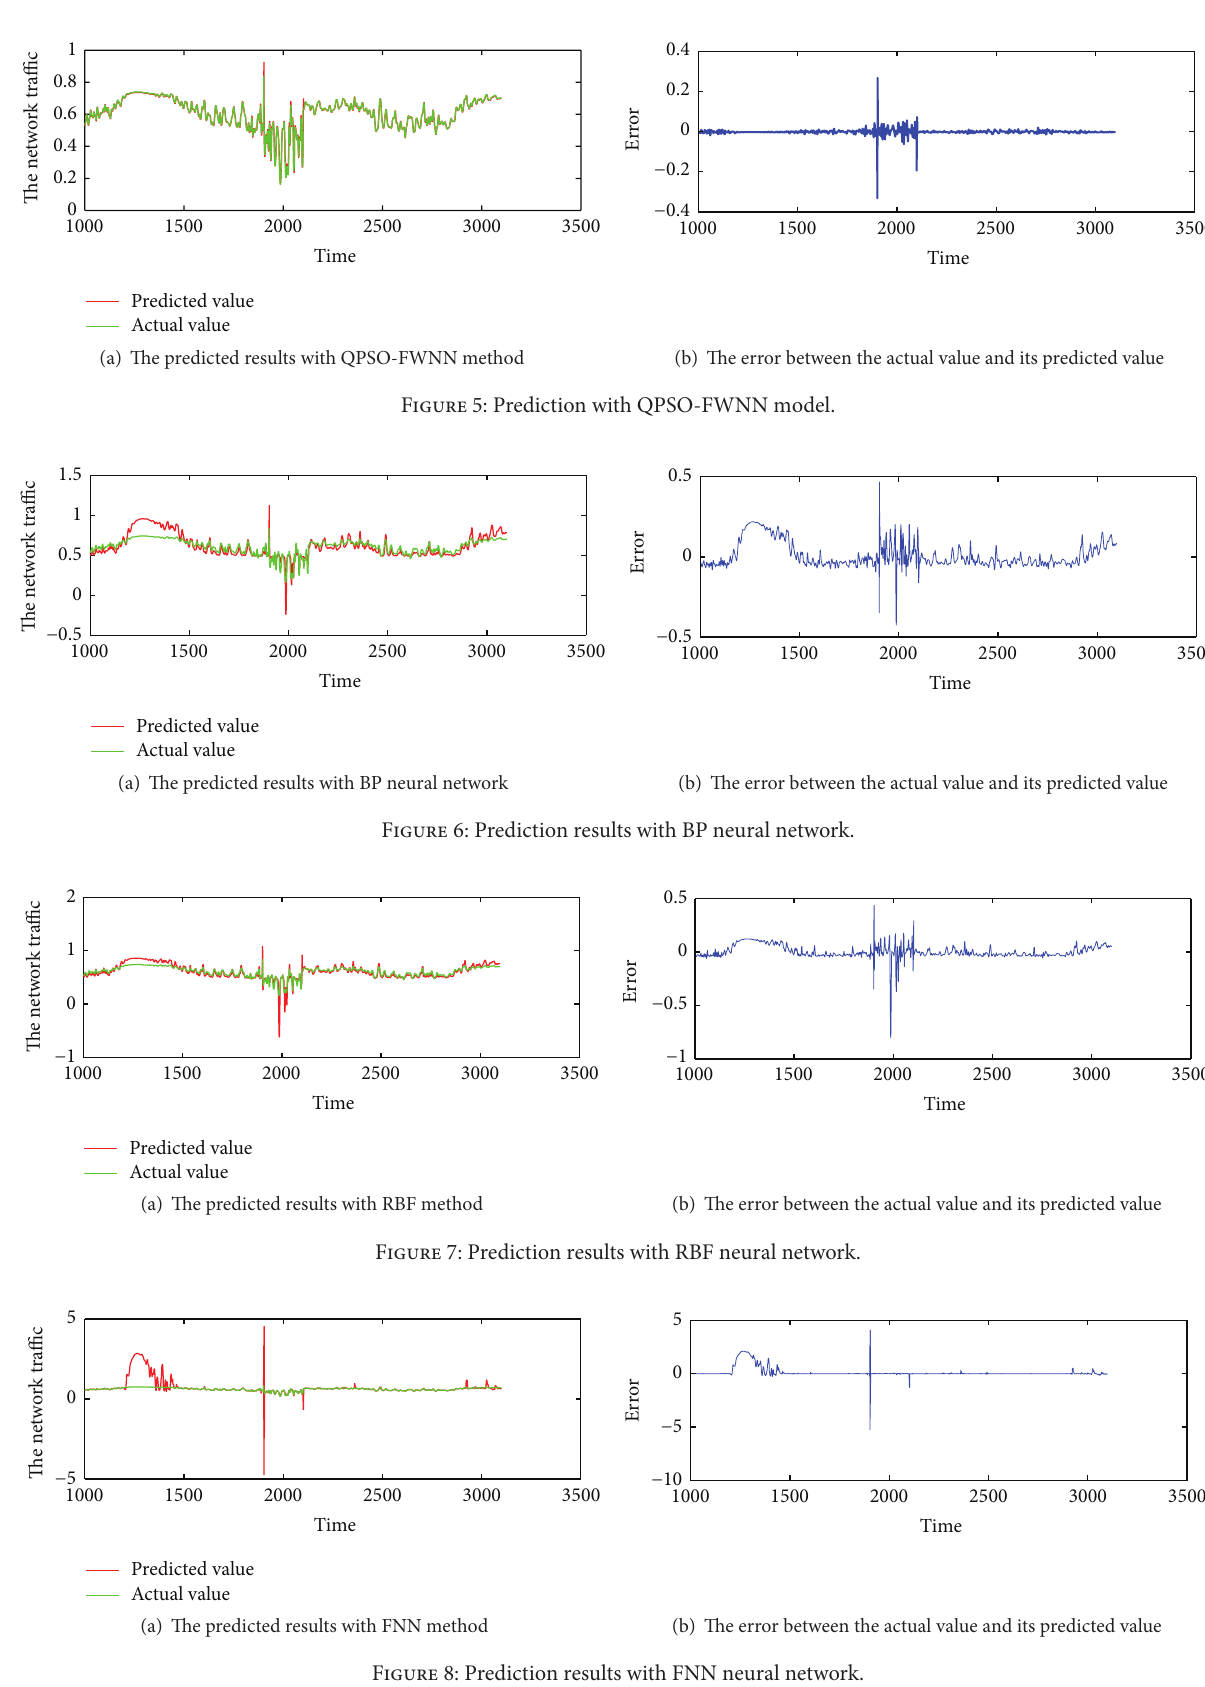
Figure 8: Prediction results with FNN neural